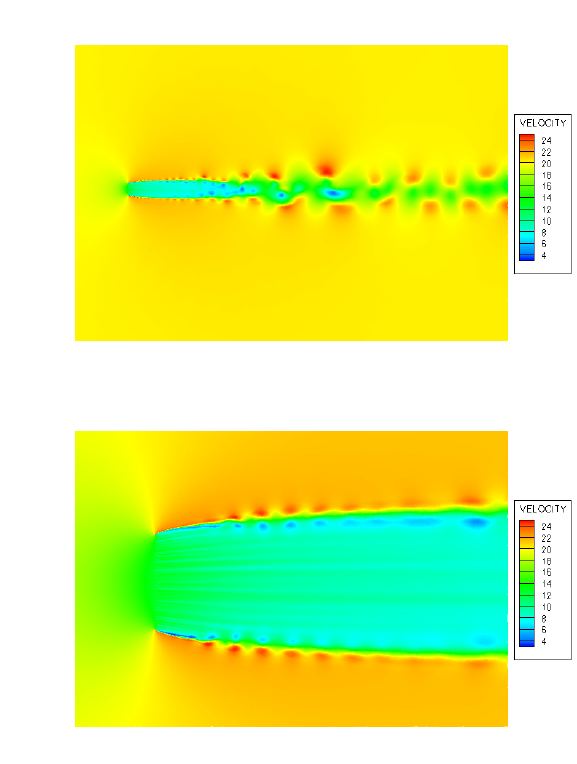
Fig. 3. The distribution of the velocity for the porous media for 20 ms − 1